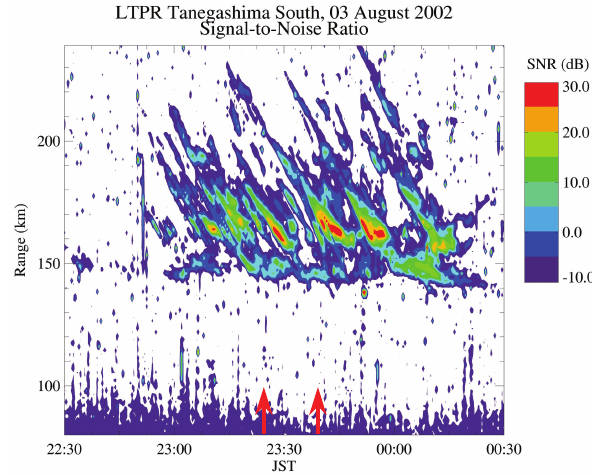
Fig. 3. Range-time intensity (RTI) plot of FAI echoes observed on 3 August 2002. Sounding rockets S-310-31 and S-310-32 were launched at 23:24JST and 23:39JST, respectively, as indicated by red arrows (Saito et al., 2005).